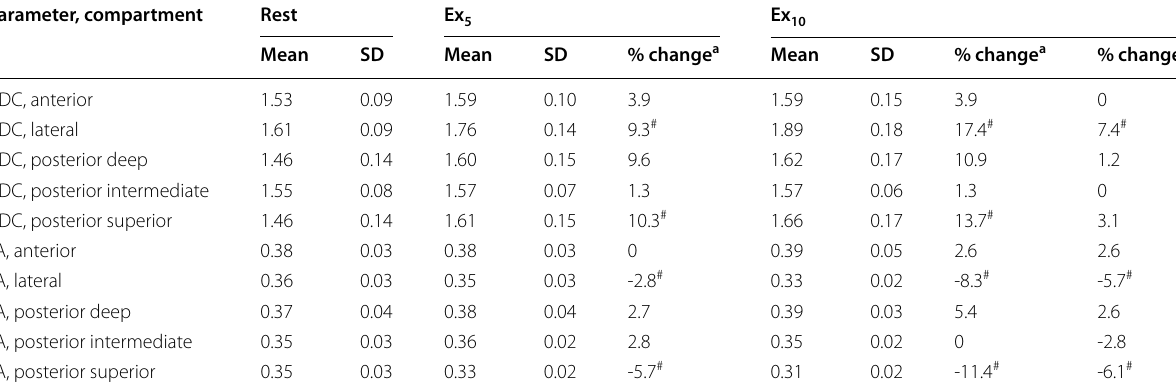
Table 1 Changes of ADC values (μm 2 /ms) and FA in muscle compartments on quantitative evaluation after each exercise